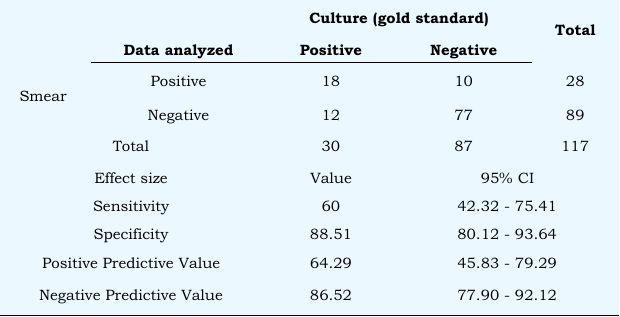
Table 3 Sensitivity and specificity, positive and negative predictive value results of cultures as a gold standard compared to direct method